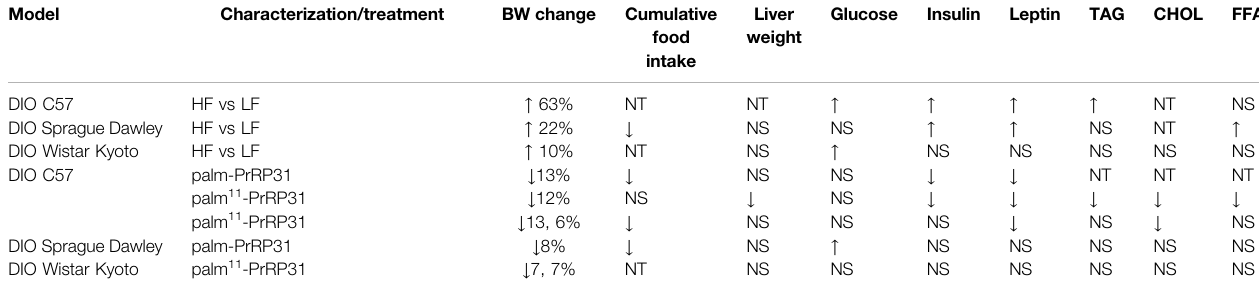
TABLE 2 | Summary of metabolic and morphometric parameters in DIO models and impact of treatment with palm-PrRP31 or palm 11 -PrRP31.